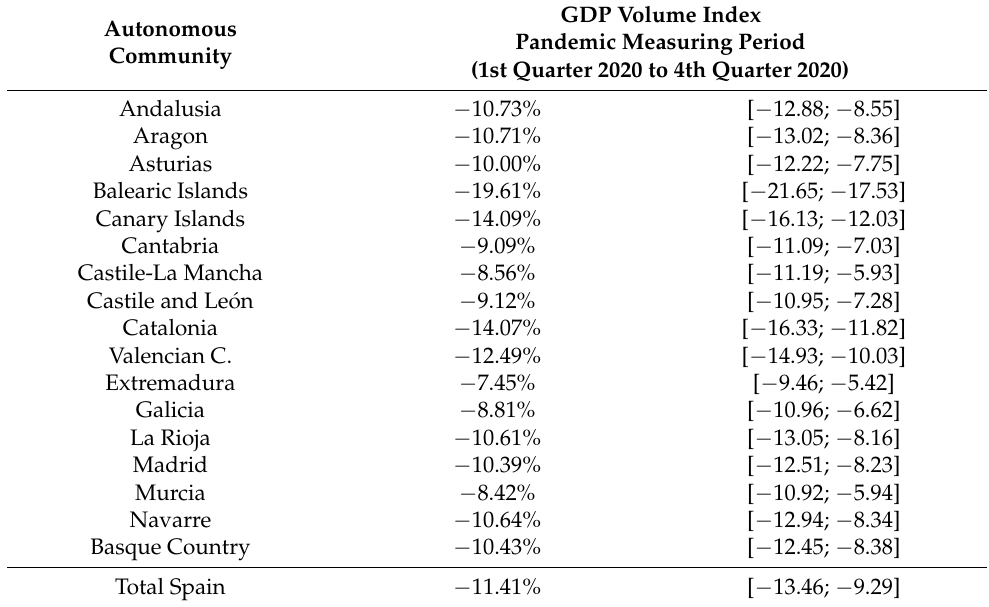
Table 2. Bayesian structural time series model results for production, supply, and demand: relative cumulative effect (95% Bayesian credible interval).